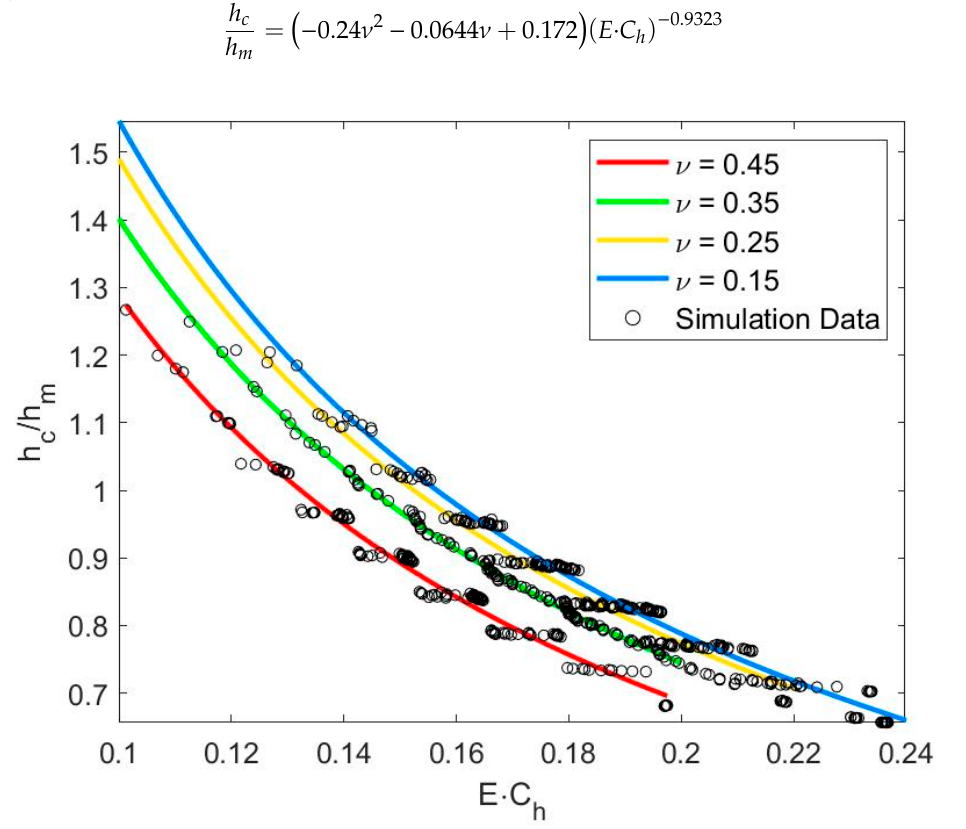
/ h θ = 70.3 ◦ · C c m and E h for